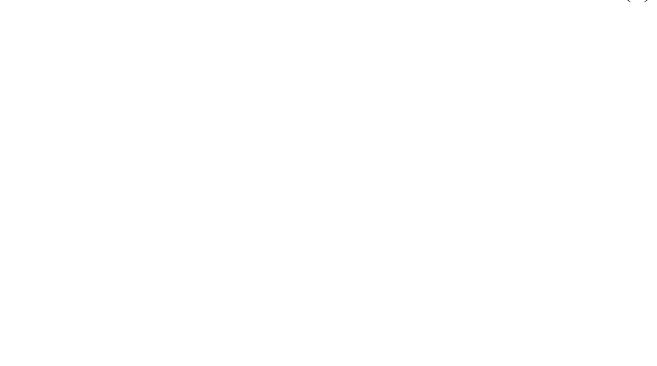
is the (cid:3037)